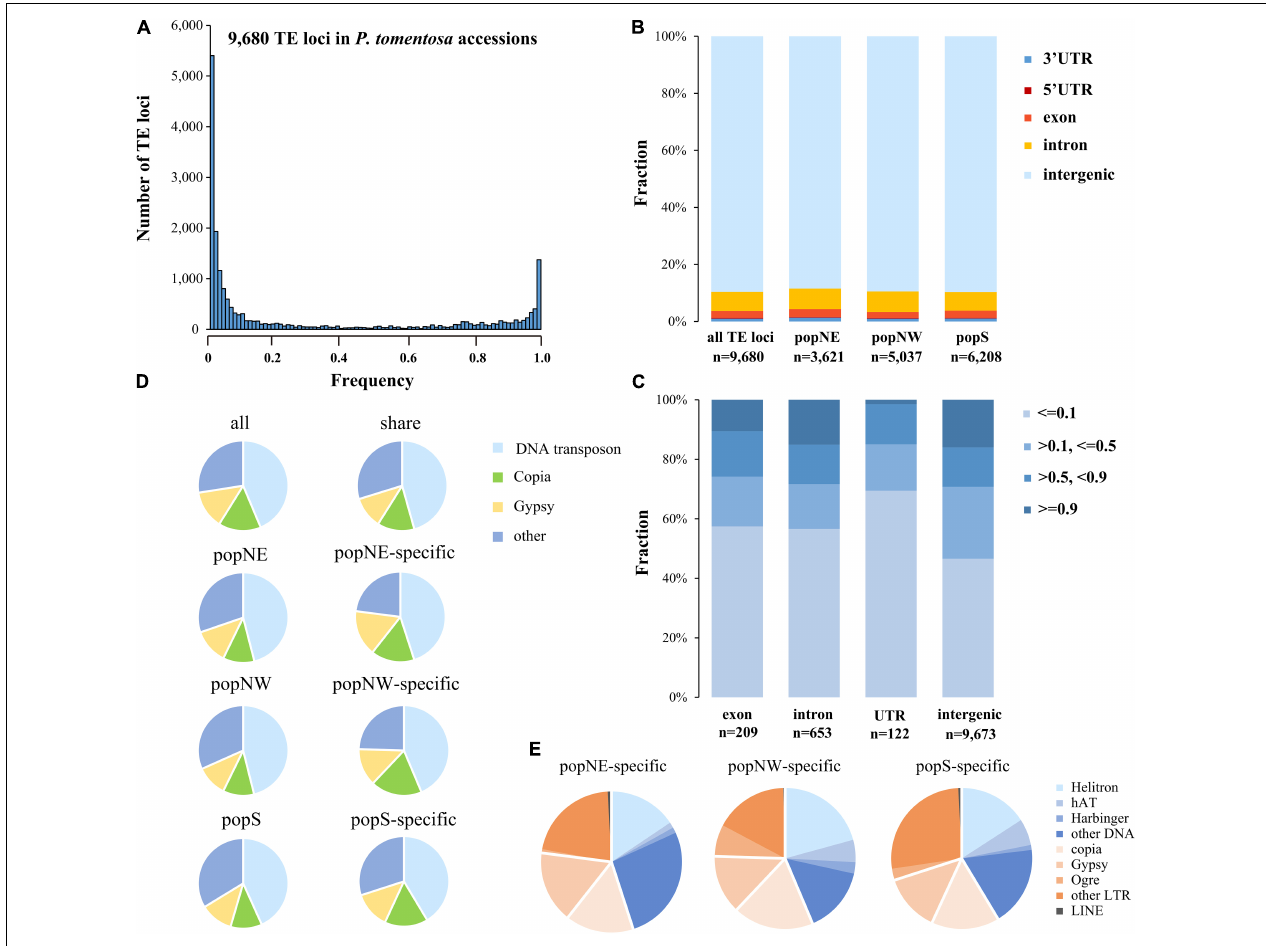
FIGURE 4 | Frequency and distribution of polymorphisms TEs in P. tomentosa population. (A) Frequency distribution of polymorphic TEs in the genomes of P. tomentosa natural population. The x -axis represents the number of additions with the same TE insertion. (B) Distribution pattern of polymorphic TEs in the genome. (C) Frequency of polymorphic TEs located in different genomic regions. (D) The composition of polymorphic TEs in different groups (including all groups, shared groups, and specific groups). (E) Composition of different types of polymorphic TEs in different specific